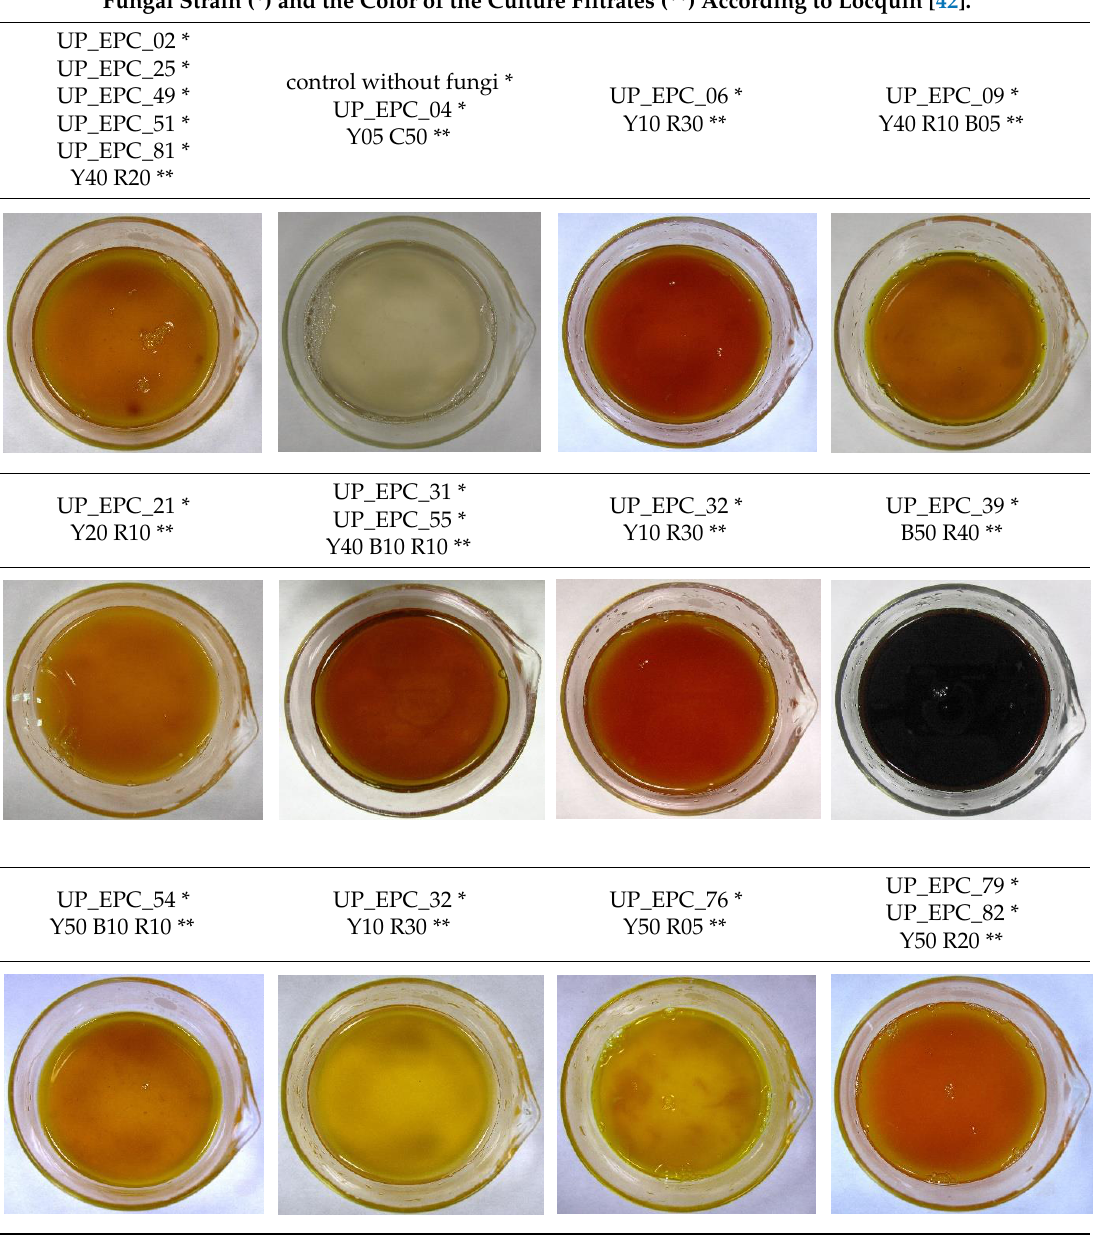
Table 2. The color of the culture filtrates obtained from 18 strains of E. nigrum after 14 days of incubation in Sabouraud dextrose broth at 25 ± 1 ◦ C, which were used for further research. Fungal Strain (*) and the Color of the Culture Filtrates (**) According to Locquin